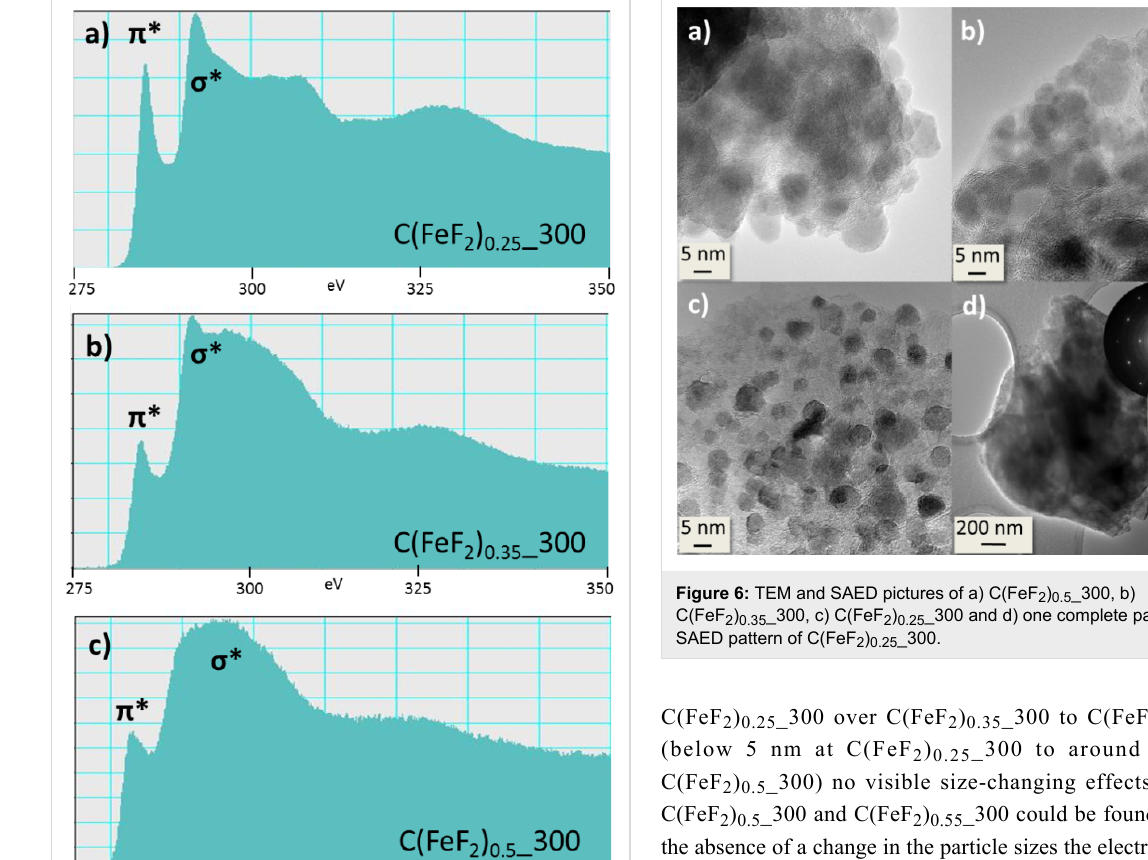
pectively. In comparison, in the C(FeF 2 ) 0.5 _300 system, the FeF 2 particles are packed most densely. The FeF 2 particles in the C(FeF 2 ) 0.25 _300 system have smaller diameters, mostly below 5 nm, and are more dispersed by the graphitic layers, which can be because of the higher atomic percentage of carbon. While the FeF 2 particle size increases slightly from